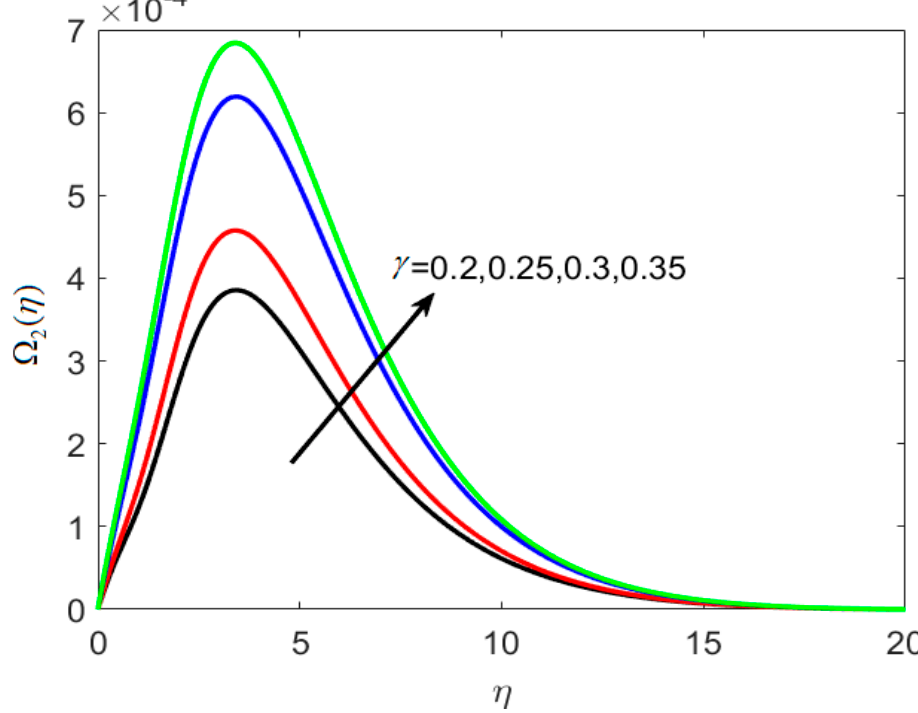
γ by taking γ by taking